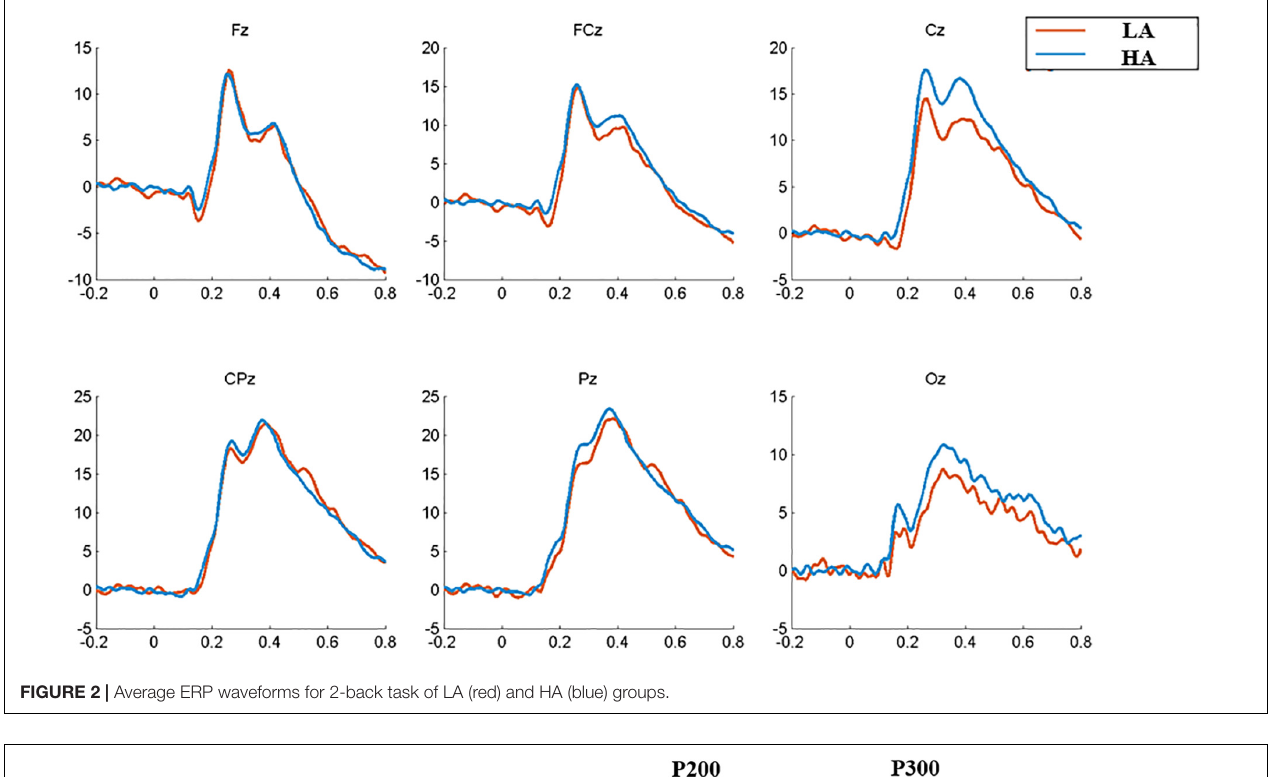
RT. Additionally, Cohen’s d results ( Table 2 ) indicated an intermediate effect size between the HA and the LA groups’ performances for the